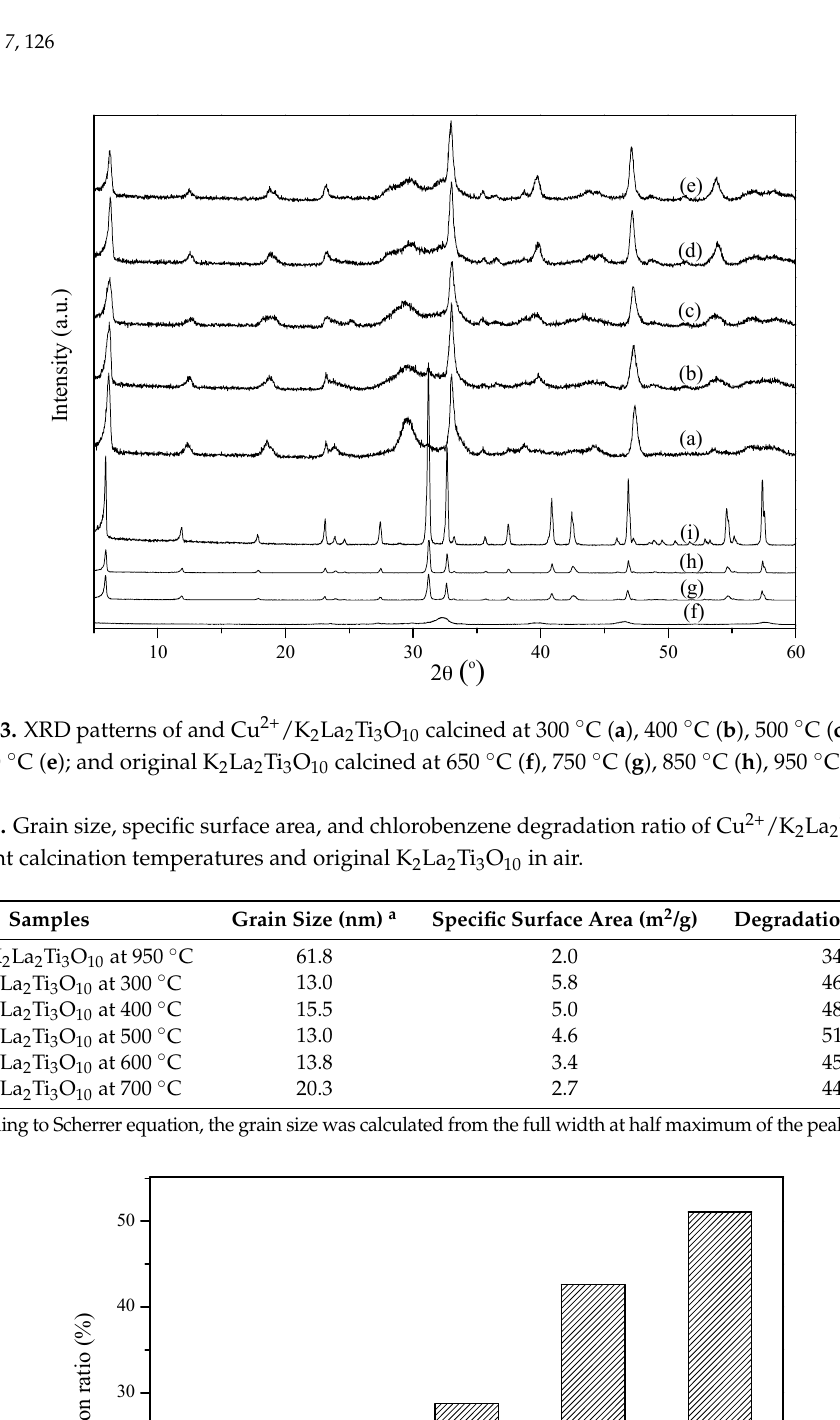
Figure 4. Comparison of photocatalyltic activities with: ( a ) Ni 2+ /K 2 La 2 Ti 3 O 10 , ( b ) Sn 2+ /K 2 La 2 Ti 3 O 10 , ( c ) Ce 2+ /K 2 La 2 Ti 3 O 10 , ( d ) Fe 2+ /K 2 La 2 Ti 3 O 10 , and ( e ) Cu 2+ /K 2 La 2 Ti 3 O 10 .